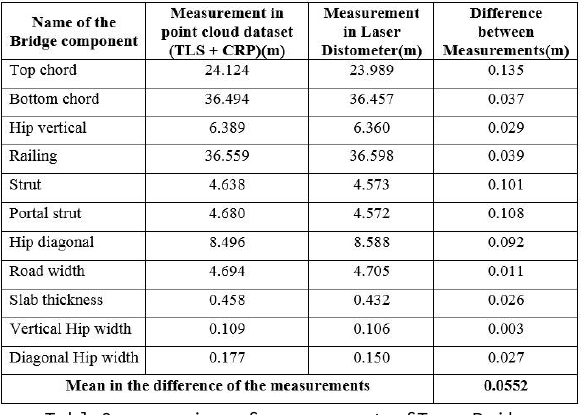
Table 3: comparison of measurements of Truss Bridge The deflections in the deck linearity is measured at different sample intervals between both the ends of abutment.